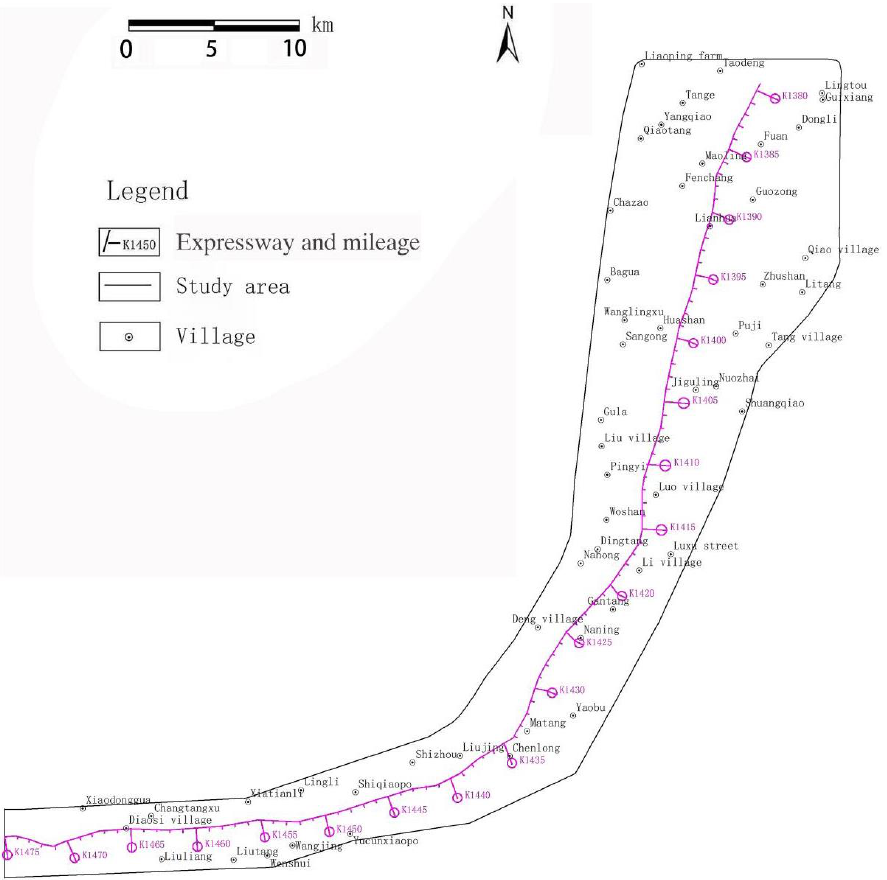
Figure 2. The range of study area.